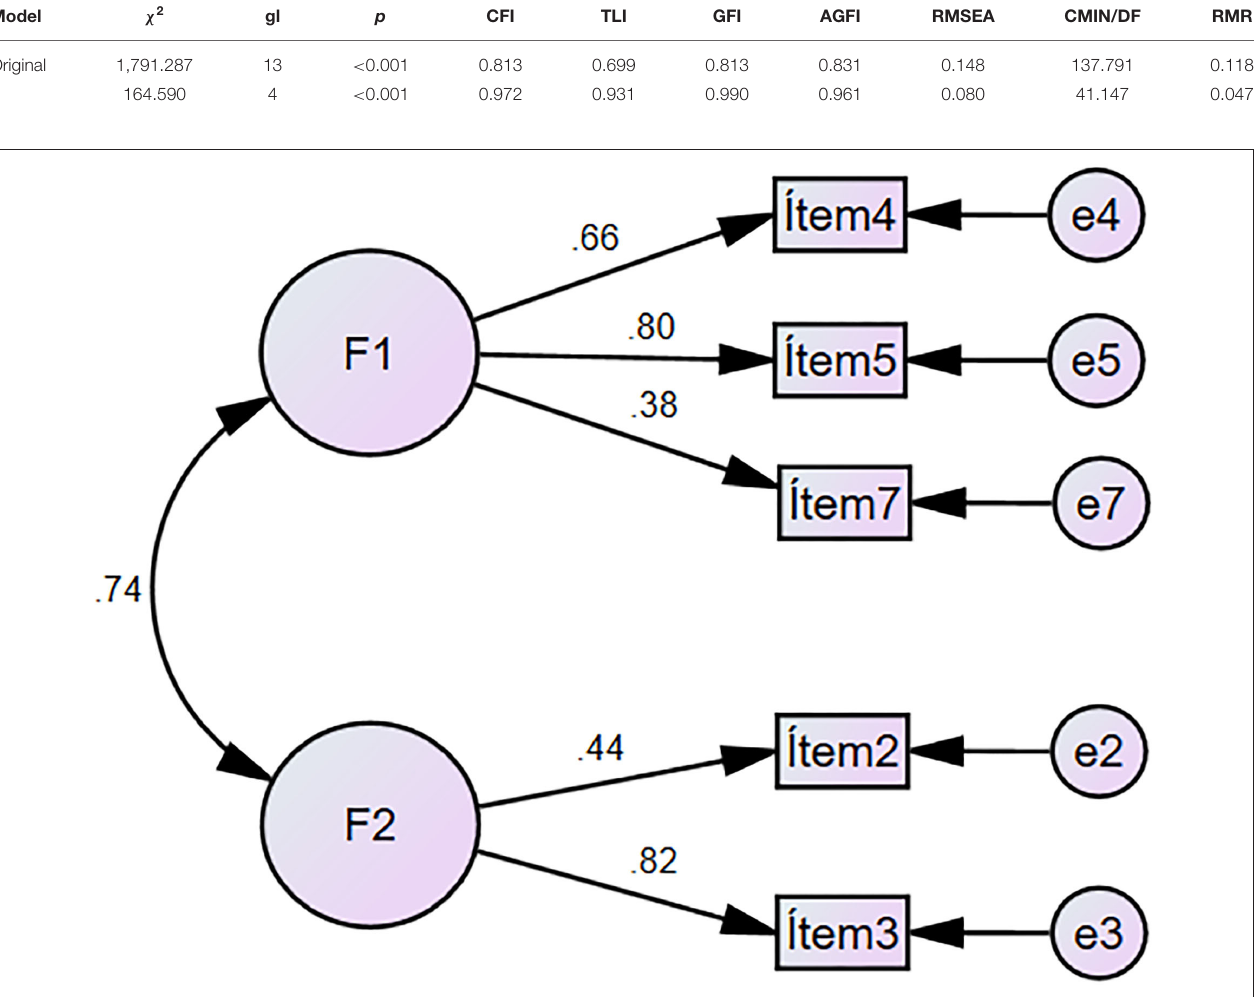
FIGURE 1 | Model 1 of the FAT-LAT-COVID-19 Scale.